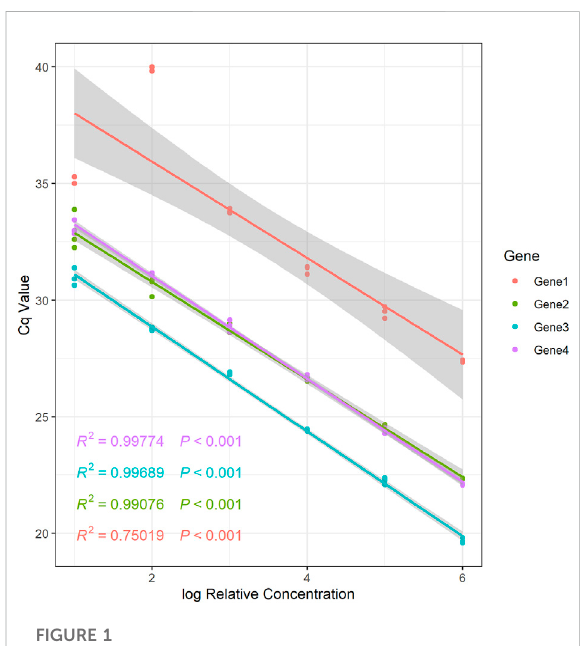
FIGURE 1 The relative standard curve of example